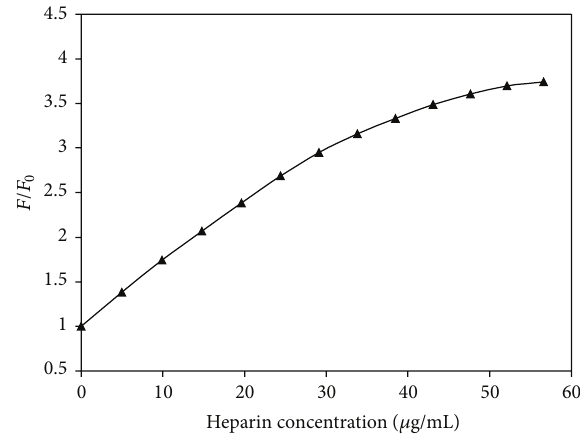
Figure 4: Plot of the luminescence enhancement ratio ( 𝐹/𝐹 0 ) of [Os(bpy) 2 CO(4-phpy)](PF 6 ) 2 at 560 nm in ethanol solution (2.8 mg/100mL) versus heparin